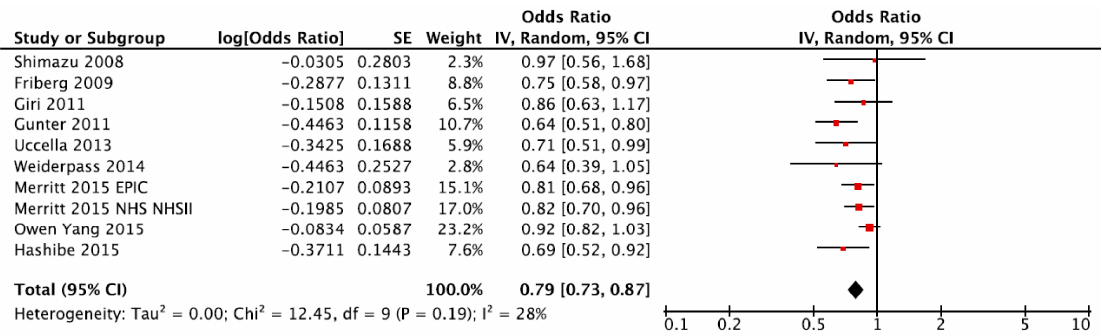
Figure 2. Forest plot of summary relative risks (RRs) of endometrial cancer for the highest versus the lowest (reference) category of coffee consumption. Exposure categories are reported as identified in the original studies; in the dose–response analysis they were harmonized (range: 0–9 cups).